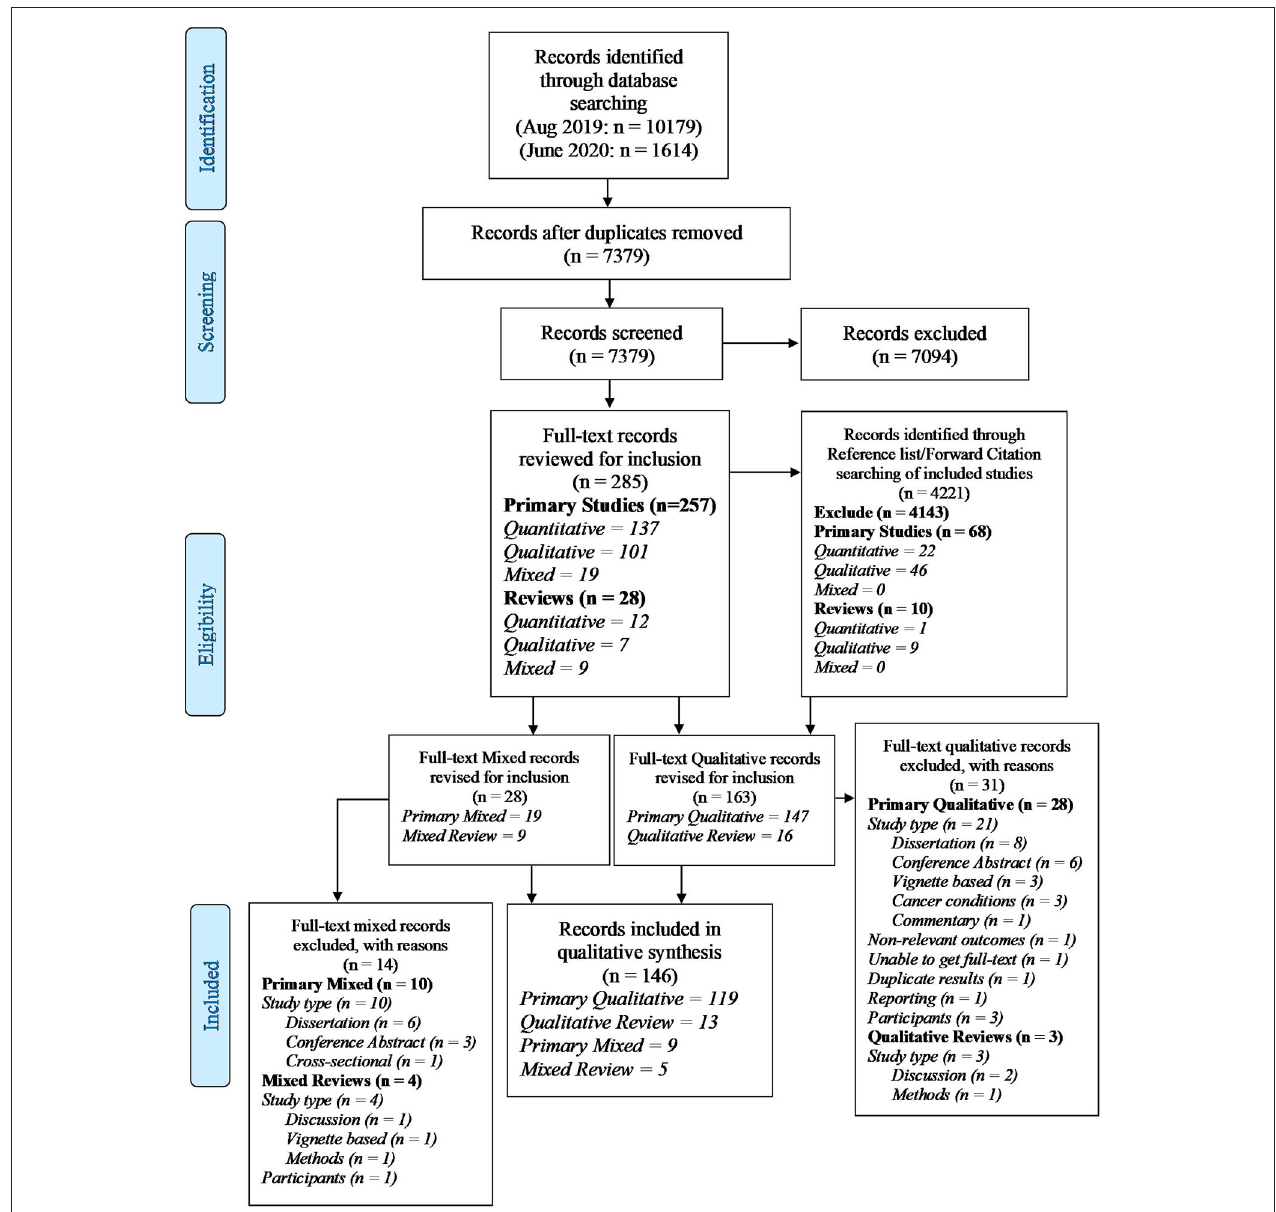
FIGURE 1 | PRISMA-ScR flow